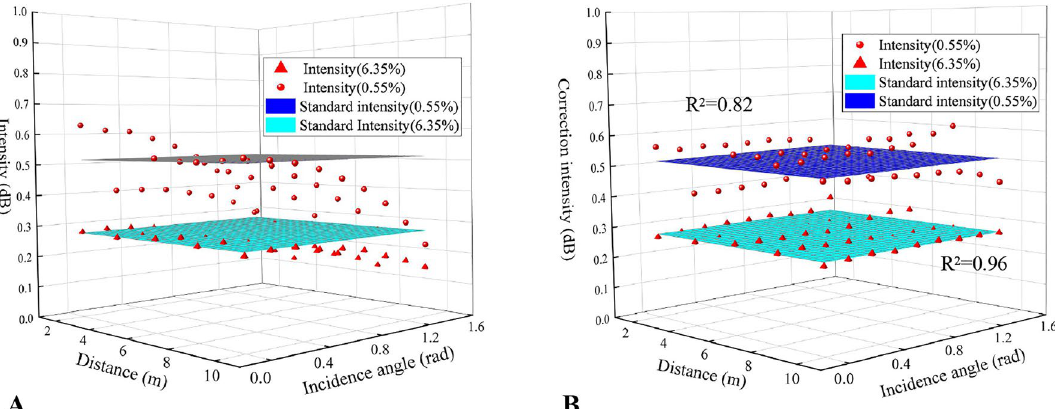
Figure 10. Intensity value before correction ( A ) and after correction ( B ) with the standard intensity of the normal incidence angle and 8 m (Software: Riscan pro 2.1; riscan-pro.software.informer.com; Origin 2021b; https:// www. origi nlab. com/ index. aspx? go= PRODU CTS/ Origin). Standard